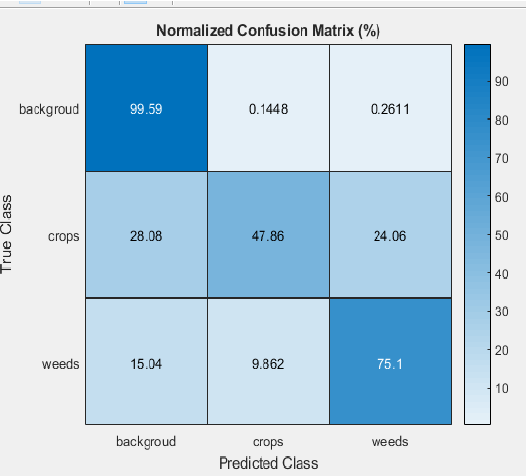
Table 2. Confusion matrix of FCN-8s Classification( unit- percentage)